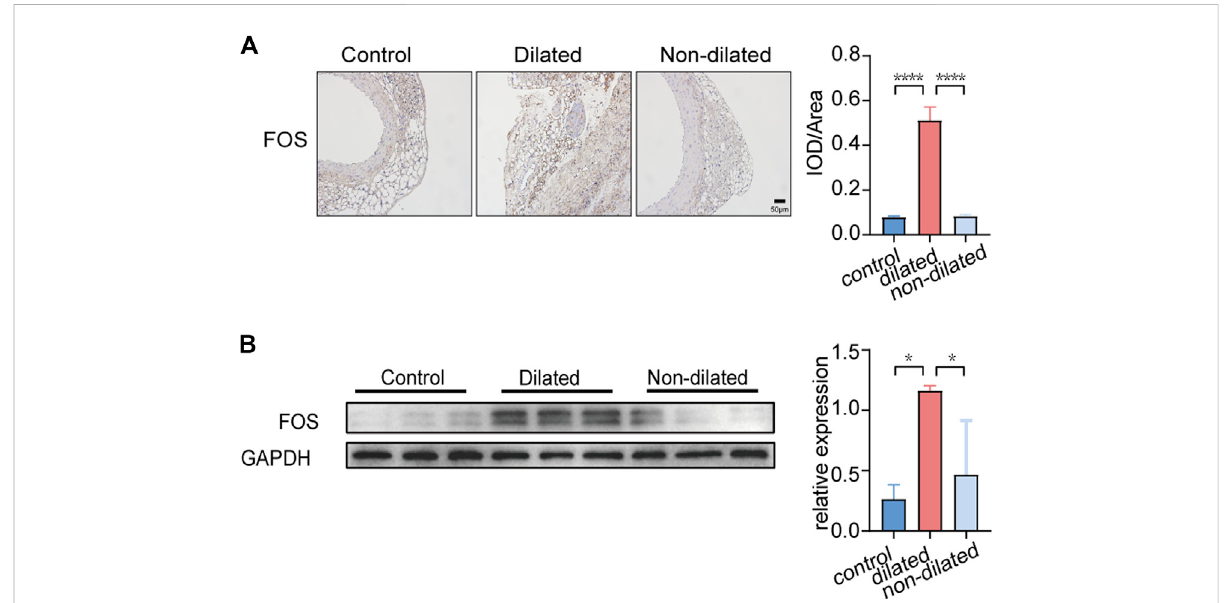
FIGURE 6 FOSexpressioninPVATofcontrolandAAAmice. (A) ImmunohistochemistrystainingofFOSexpression.Scalebar=50 μ m.* p < 0.05.Datawere analyzed by one-way ANOVA. (B) Western blot analysis and corresponding quanti fi cation of FOS expression (GAPDH is loading control), * p < 0.05. Data were analyzed by one-way